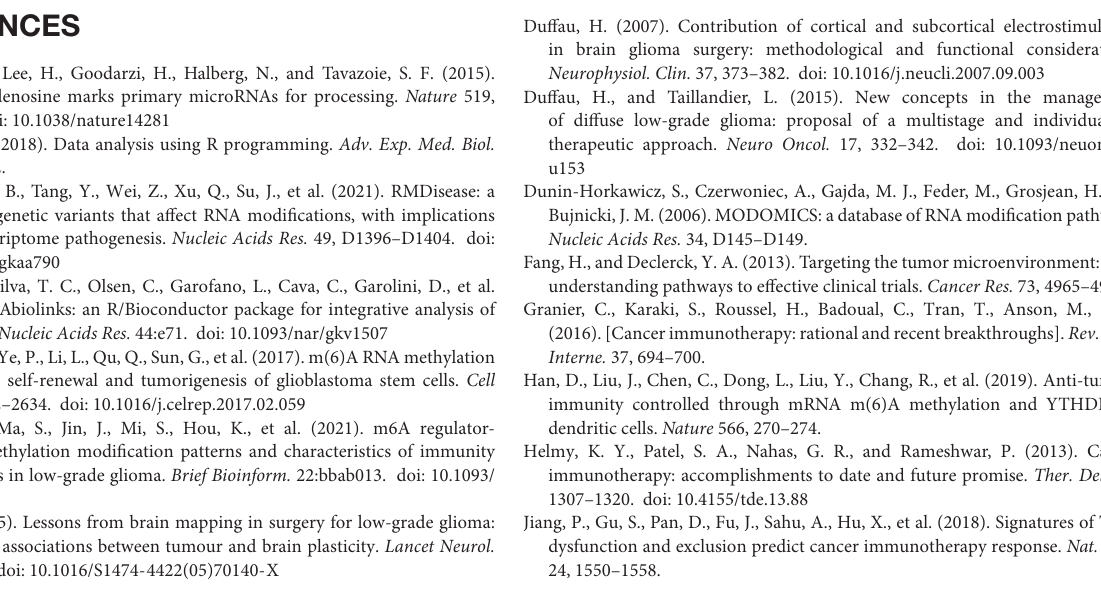
Supplementary Figure 1 | The flowchart of our research. Supplementary Figure 2 | The relationship between m6A regulators and the prognosis of